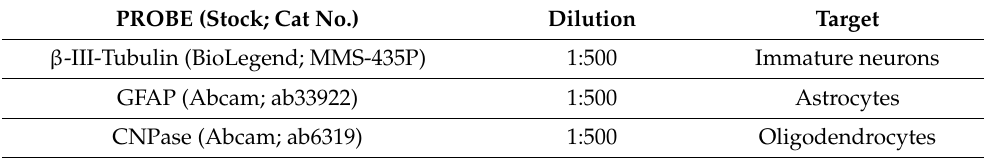
Table 1. Antibodies used to assess differentiation profile of cultured hiPSC-NPCs. PROBE (Stock; Cat No.)